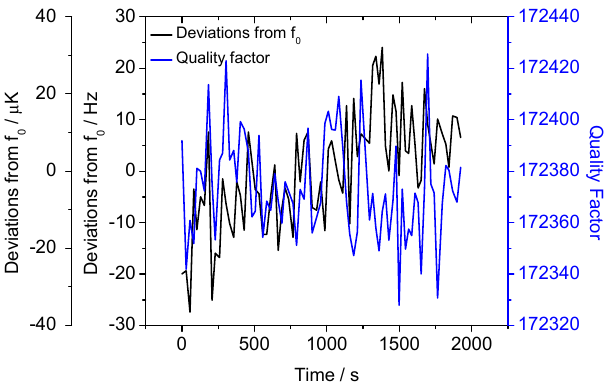
Figure 13. SWGT resonance frequency and Q factor deviations when the microwave resonator is placed inside a melting ice bath. It is worth comparing the SWGT measurement stability with the SPRT temperature stability, since they were both hosted in the same copper cavity and were in thermal equi- librium during the whole experiment. The temperature fluctuations detected by the SPRT were thus converted into equivalent resonant frequency deviations by using the SWGT sensitivity ( S SWGT ). ∆𝑓 = ∆𝑇 (cid:3020)(cid:3017)(cid:3019)(cid:3021) ∙ 𝑆 (cid:3020)(cid:3024)(cid:3008)(cid:3021) (7) The SWGT measurement stability was about five times better than the equivalent SPRT stability. This comparison is shown in Figure 14. This result is in line with that re- ported in the literature [13] for a SWGT and confirms the good performance of this device for temperature measurements. Figure 14. Comparison between the measurement stability of SWGT (black squares) and SPRT (red circles). In this plot the SPRT resistance deviations have been converted into equivalent frequency deviations. The SWGT measurement stability is about five times better than the SPRT. Beside stability, the SWGT repeatability at the ice melting point was evaluated, as well. Measurements were repeated several times with different realizations of the ice point, each time recording the temperature from SPRT and the equivalent temperature